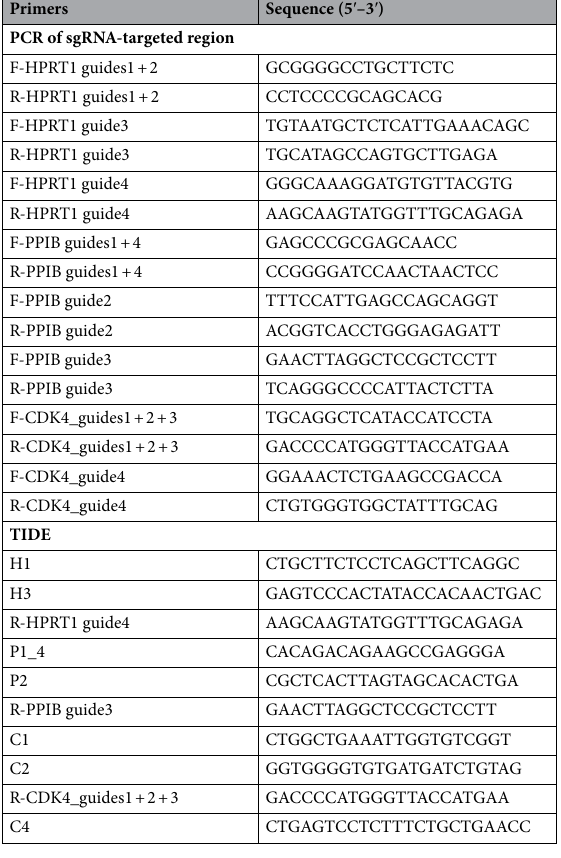
Table 3. Primers to amplify sgRNA-targeted region and for